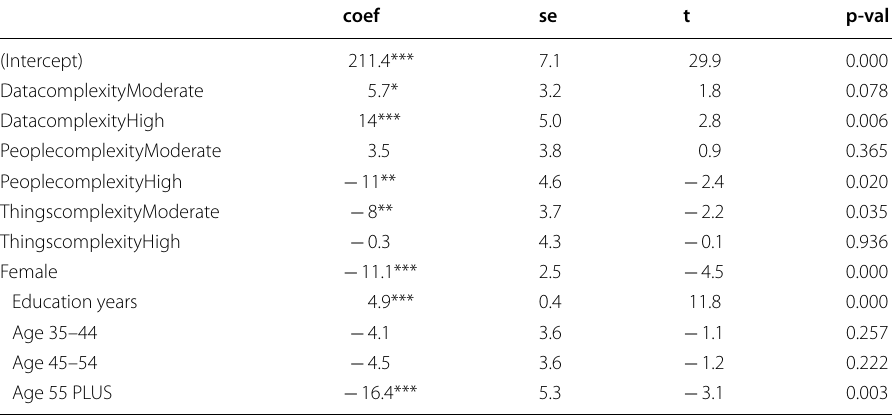
Table 15 Regression results for Italy. Source: PIAAC 2012, DOT index, ISCO-08 codes